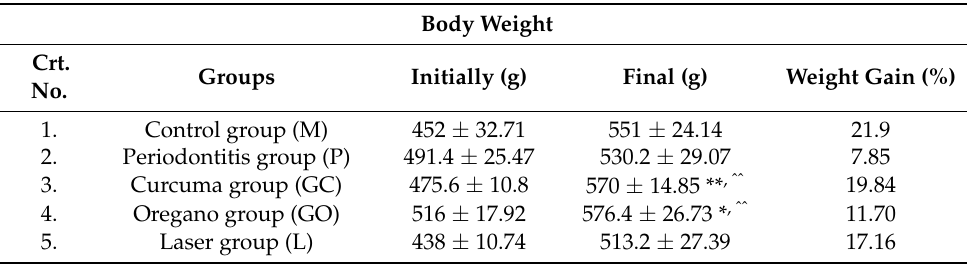
Table 1. Mean weight change (standard deviation) and weight variability (g) before and after treatment.